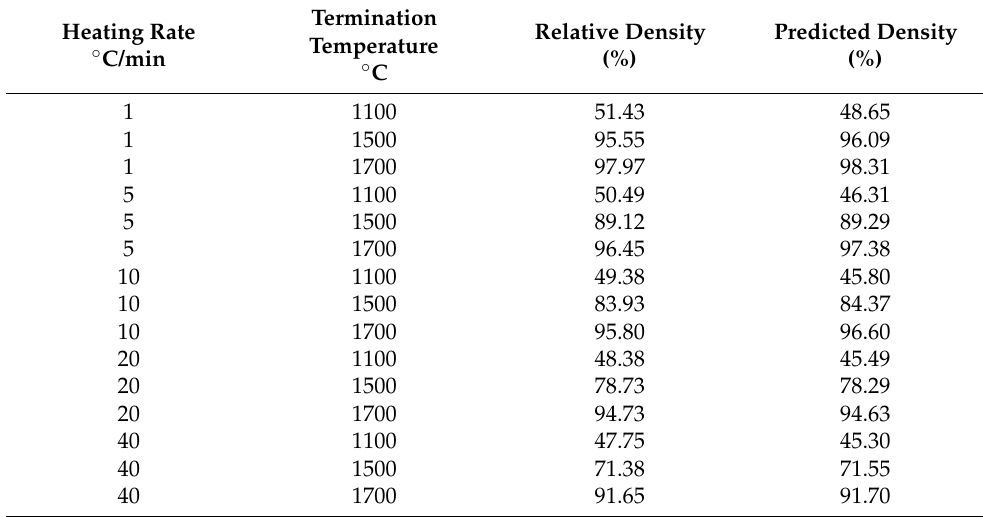
Table 1. The experimentally measured and predicted relative density using master sintering curves for different sintering procedure.